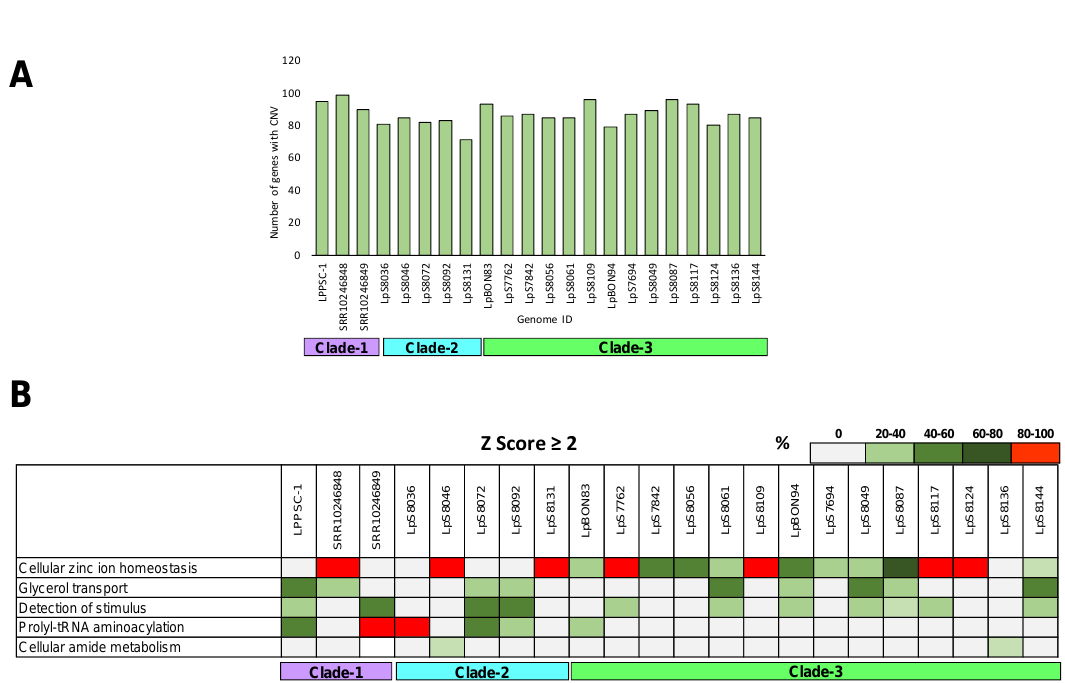
Figure 3. Evaluation of copy number variation (CNV) genes and ontology enrichment analyses . The